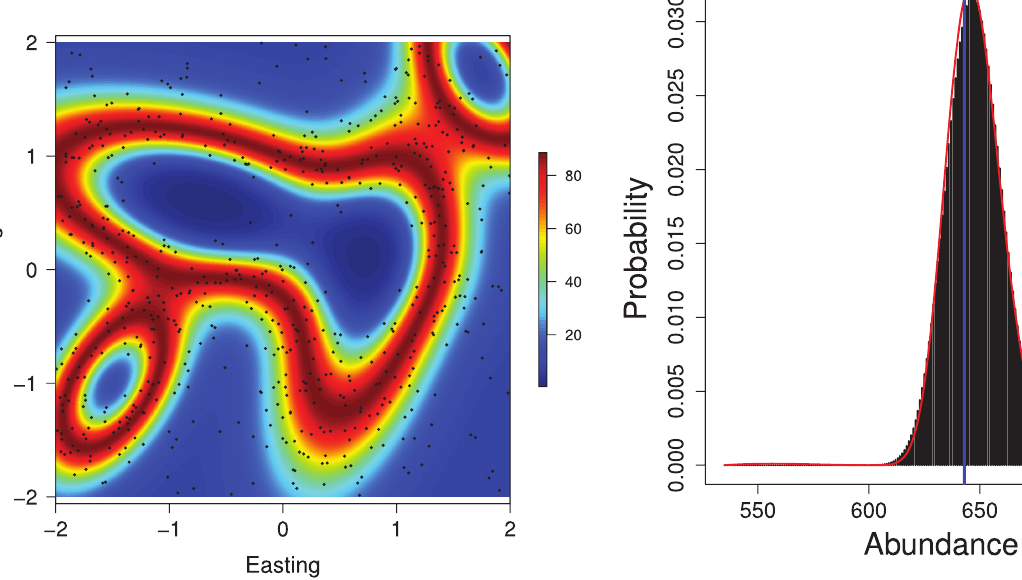
Figure 4. Posterior distribution of abundance of simulated population. Red line indicates the estimated sampling distribution of empirical Bayes estimates of abundance. Vertical blue line indicates true population size.